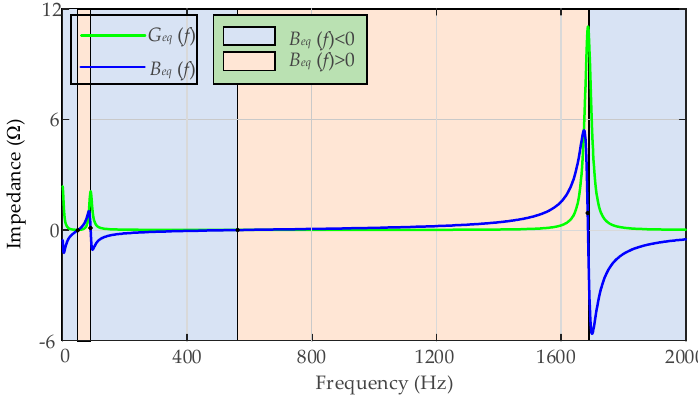
Figure 4. Effect of frequency on G eq ( f ) and B eq ( f ).